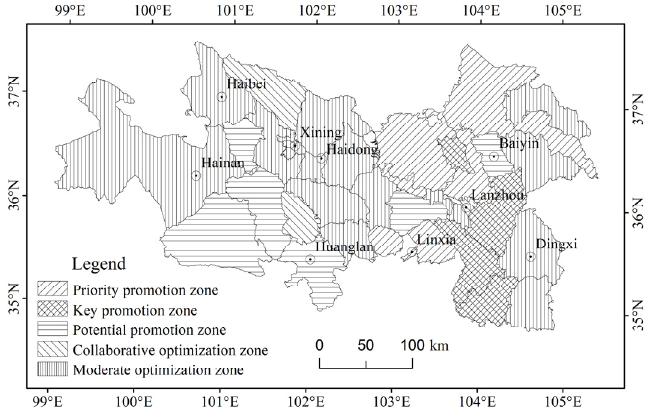
Figure 10. Governance zones of LUFs.